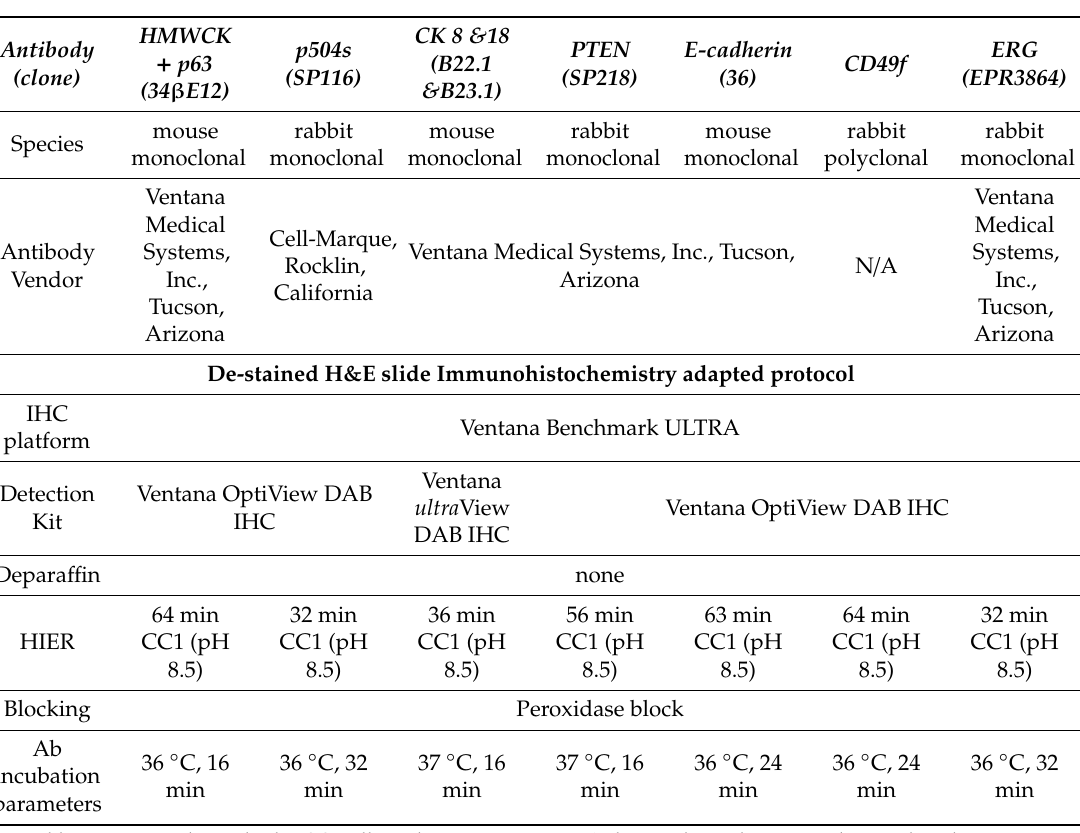
Table 3. Immunohistochemistry (IHC) Antibodies and Adapted Staining